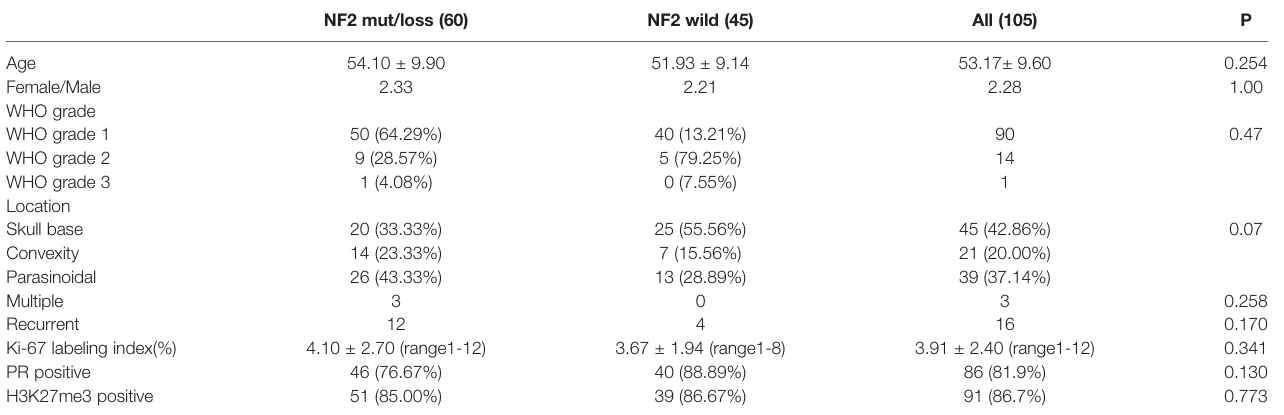
TABLE 1 | Clinical data of enrolled